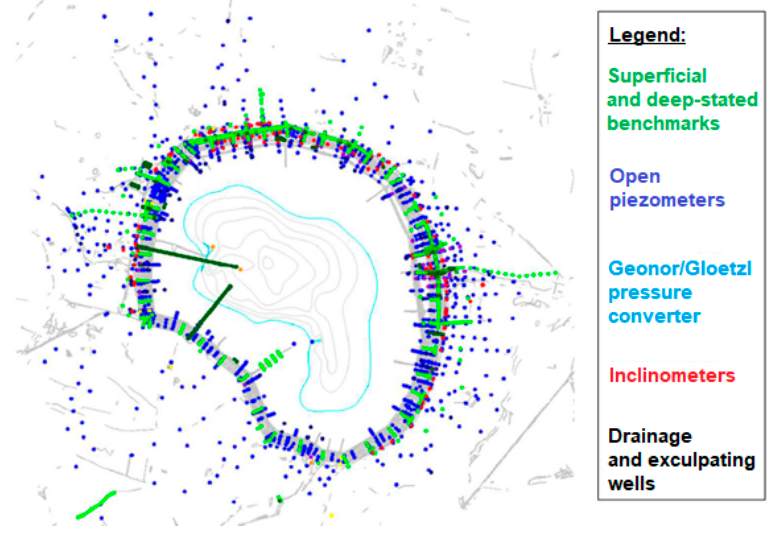
Figure 3. Distribution of measurement and control equipment around the pond.